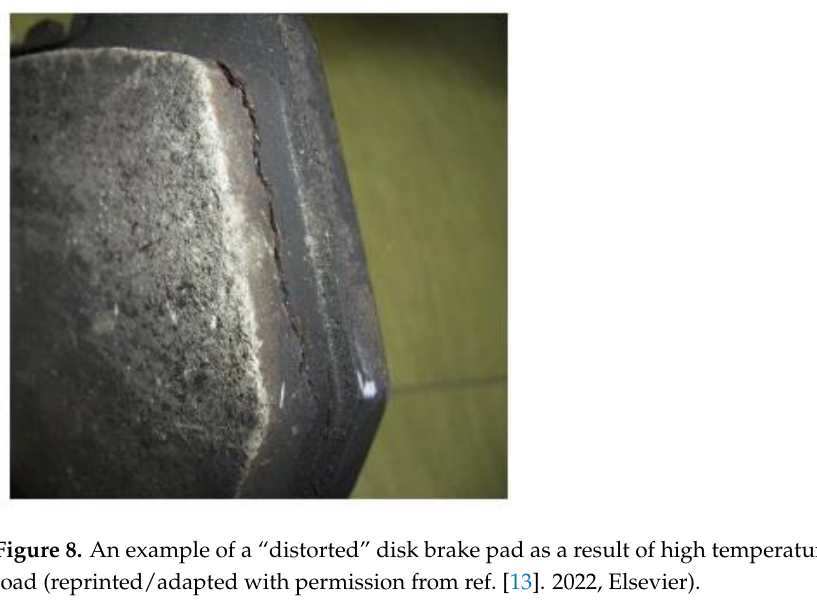
10 of 15 Figure 7. Model of a braking friction couple “five - phase” (cast iron disk and compos ite friction material), which includes a bond with resin (reprinted/adapted with permission from ref. [13]. 2022, Elsevier). When a brake friction material is subject to operation at a temperature high enough to cause fading, it is expected that, when allowed to cool, the friction coefficient, μ will return to the initial value (see Figure 6). However, there an effect that frequently occurs, known as “delayed discoloration”, where the temperature effect is largely reversible. In extreme conditions, vehicle brakes may be allowed to cool but generate a low friction coefficient value, μ , when applied. For a friction materials couple (a typical cast-iron disk associated with resin-bonded composite materials) prolonged slipping at temperatures of above 300 °C (depending on the operating conditions and material) will have an effect on the change in the friction material’s surface, and possibly in the disk thickness of the friction material. At the same time, the organic components in the friction material’s composi tion,